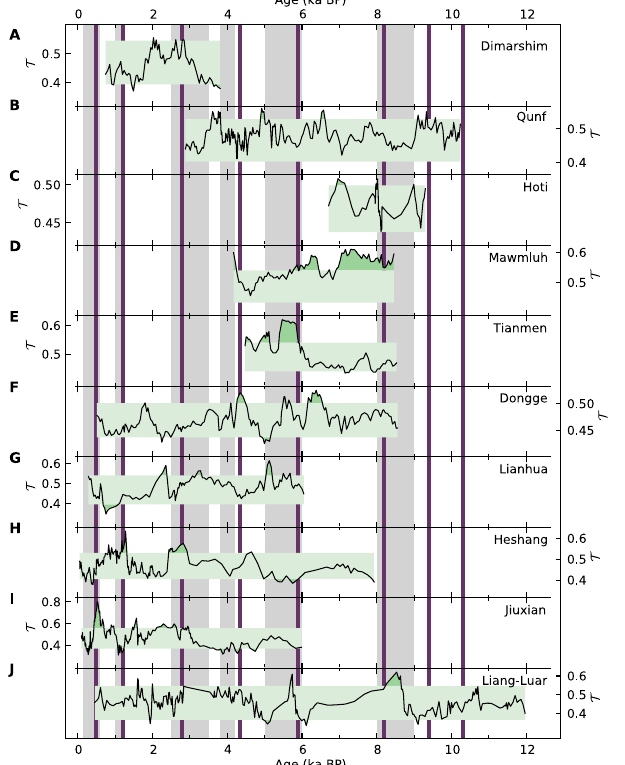
Figure 8. Time evolution of the regularity (RN transitivity T ) of variations in monsoon strength obtained as in Fig. 7. The predom- inant dynamical regime or baseline state is marked by 90% confi- dence bounds from a stationarity test (horizontal light green bands). Deviations from this baseline indicate epochs (regime shifts) with significantly enhanced or diminished climate regularity (filled-in dark green areas). Bond events (violet lines) and RCC episodes (grey bands) are displayed for reference.